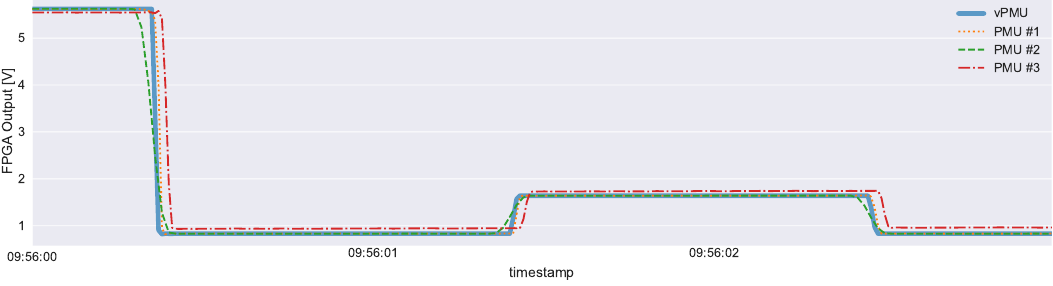
Figure 6. Time synchronized magnitudes of one phase from one virtual and three real PMUs during a fault connected to the same node. The vPMU acts as the reference signal. Note: PMU #2 has a reporting rate of 50 and the other two a reporting rate of